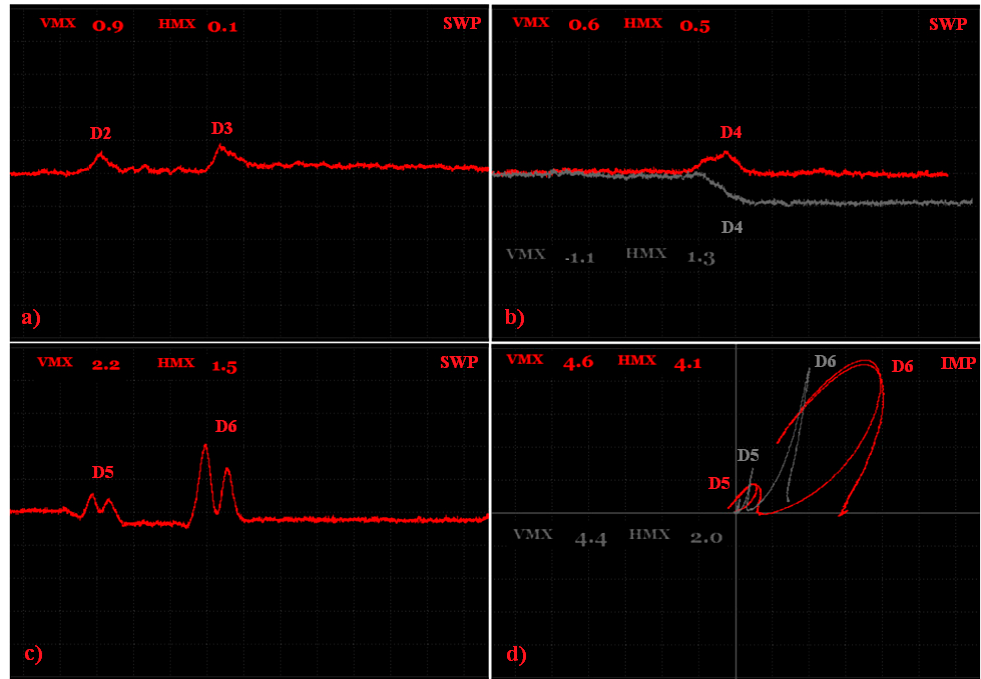
Figure 14. S3 sample, signal-to-size of defect variation; ( a ) D2 and D3 defects at 15 kHz excitation frequency; ( b ) D4 defect at 10 kHz, 135 deg. (grey curve) and 85 deg. (red curve) ANGLE comparison; ( c ) D5 and D6 defects at 10 kHz; ( d ) S3 (reversed) sample, D5, D6 (red curve) defects at 10 kHz and S2 sample, D5, D6 (grey curve) at 5 kHz comparison.